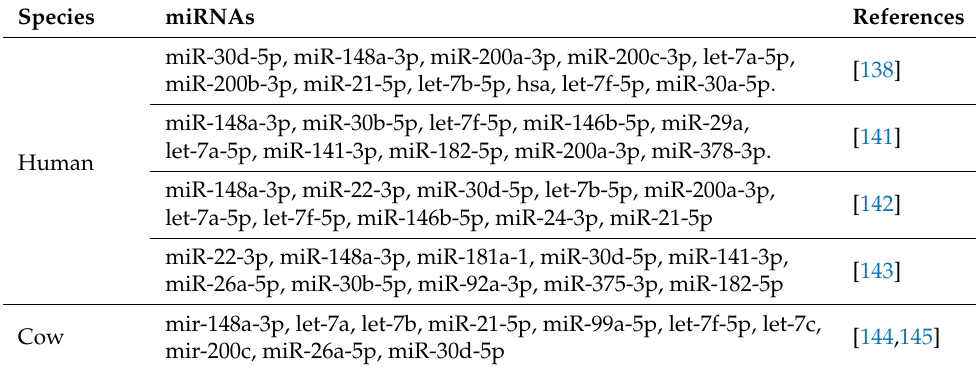
Table 4. Top miRNAs identified in milk EVs from humans and cows.